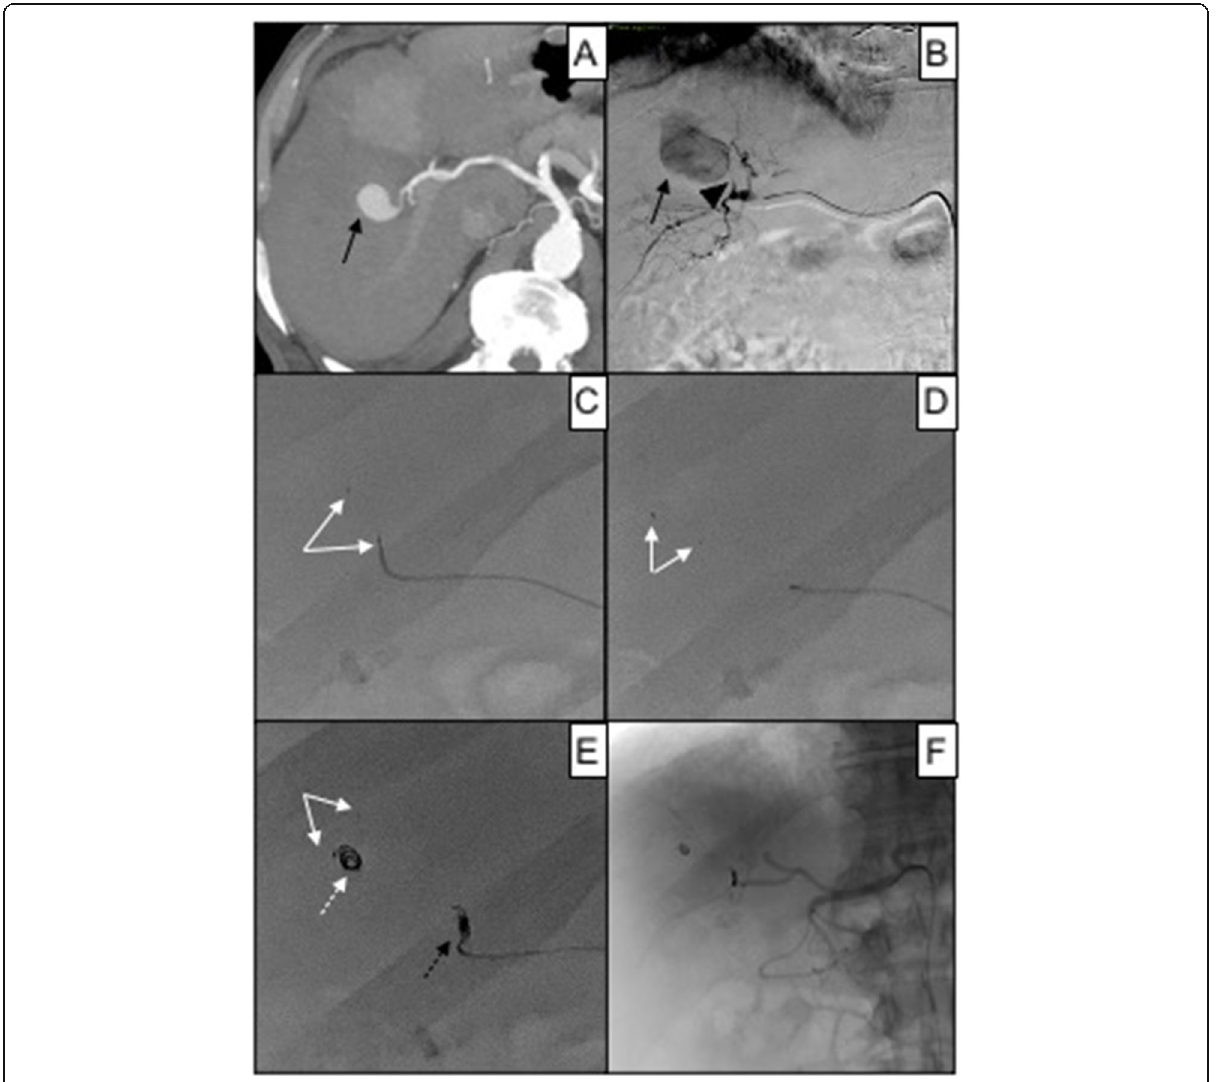
Fig. 6 83 years old female affected by iatrogenic pseudoaneurysm of the right hepatic artery after RFA for HCC. In A , a contrast-enhanced CT scan in arterial phase shows the intraparenchymal vascular lesion (black arrow); in B , superselective DSA of the right hepatic artery confirms pseudoaneurysm (black arrow) refurnished by a short arterial feeder (black arrowhead); in C , attempt to perform MVP-3 (white arrows) embolization, target vessel caliper 1.1 mm; in D , due the shortness of the arterial feeder, MVP-3 (white arrows) migrated into the pseudoaneurysm sac; in E , proper embolization was obtained with a 2 mm Concerto ® Medtronic controlled detachment coil (black dotted arrow), after that another pushable coils (white arrow) migrated into the pseudoaneurysm sac together with MVP (white arrow); in F , fluoroscopic control showing resolution of the